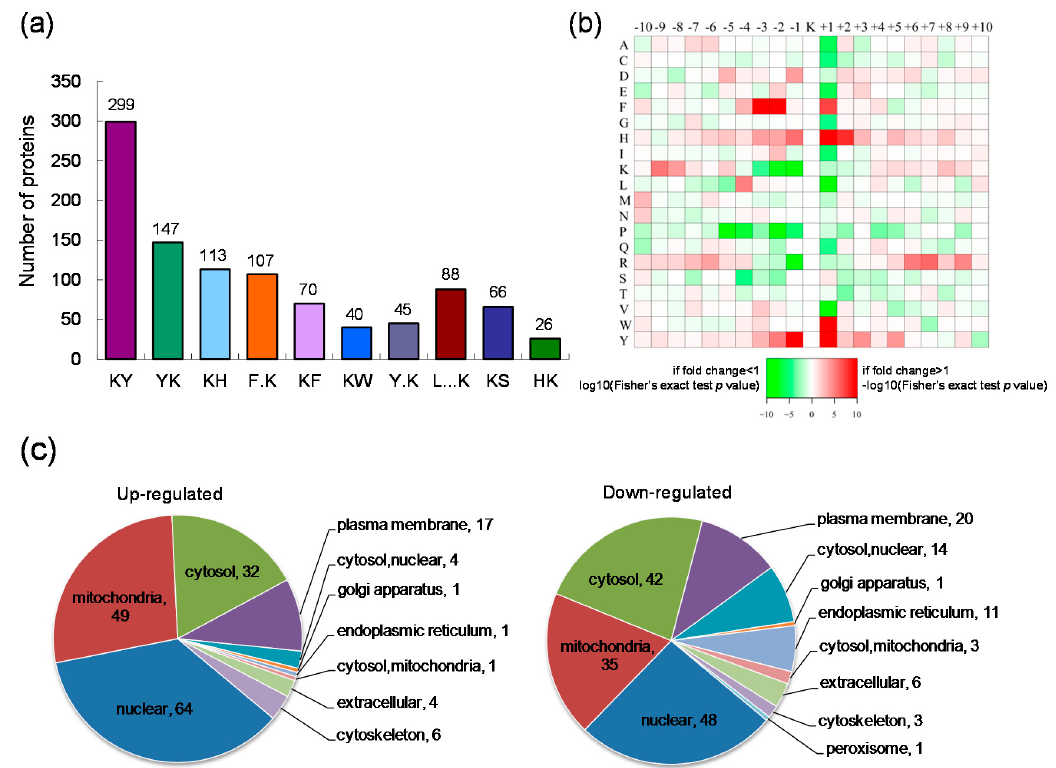
Figure 2. Motif analysis of the identified lysine acetylation sites and subcellular localization of the differentially expressed lysine acetylated proteins. ( a ) The number of identified proteins containing indicated lysine (K) acetylated motifs; ( b ) Heat map of the amino acid compositions around the acetylated lysine site (10 amino acids upstream and downstream of the K site). Red indicates abundant and green indicates least abundant; ( c ) The subcellular distribution of the up-regulated or down-regulated proteins.